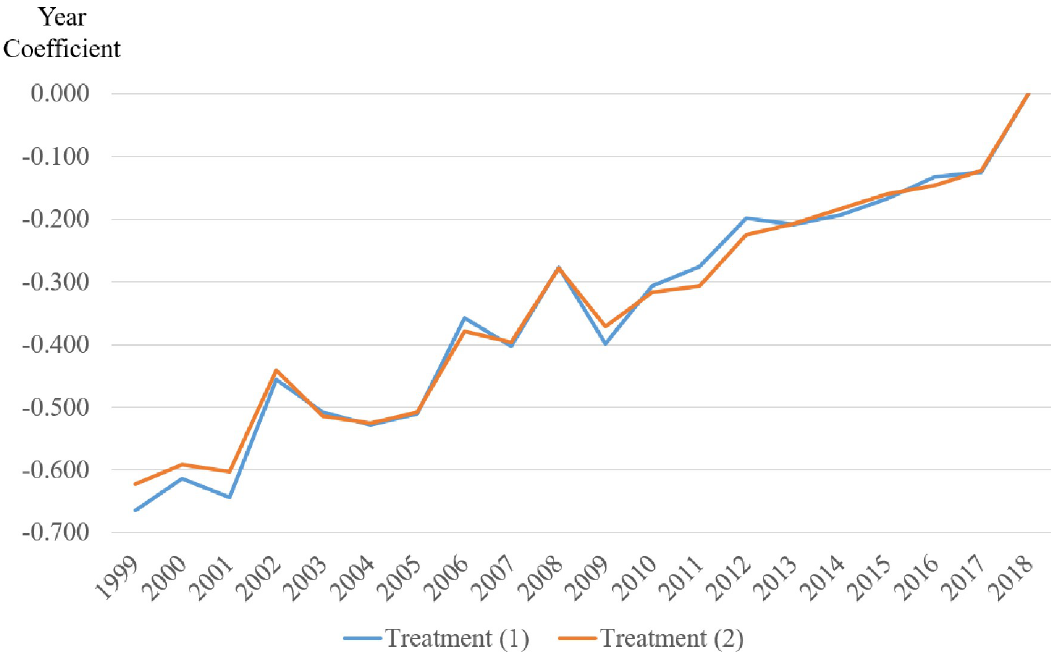
Fig 2. Trend of time coefficient as a predictor of the number of article